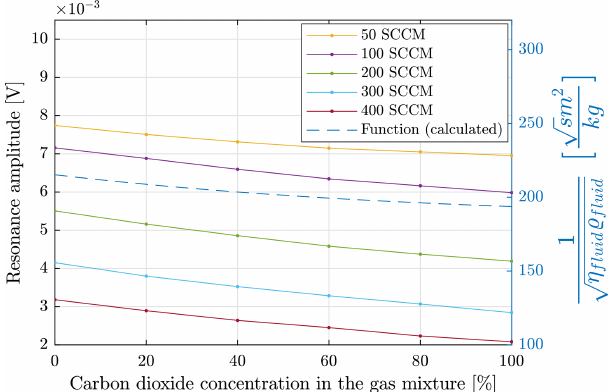
Figure 5. Resonance amplitude and function for describing the mixing properties (blue) as a function of the air–carbon-dioxide gas mixture at different volume flows.